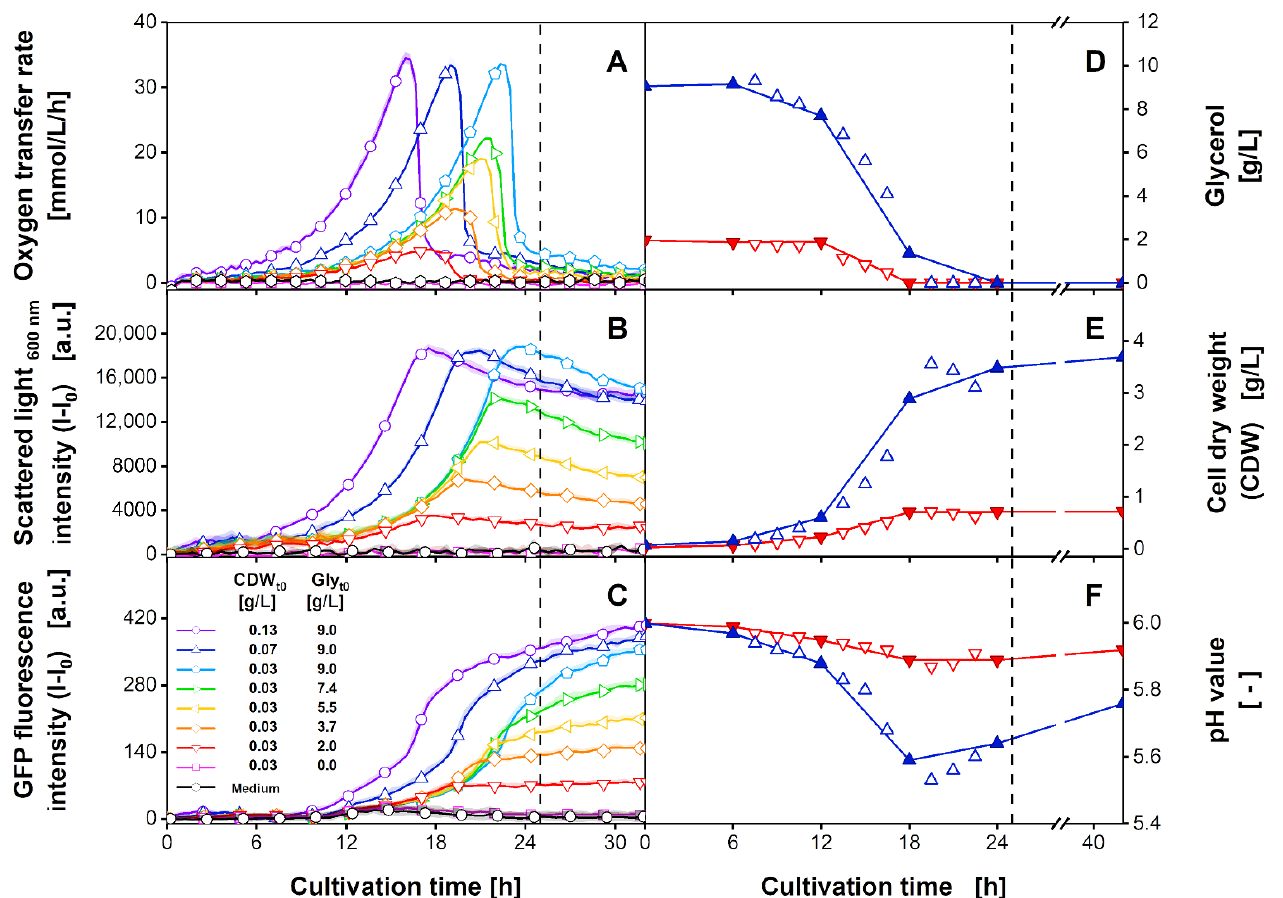
Figure 4. Time-resolved ( A – C ) online-monitoring signals and ( D – F ) offline sample measurements of H. polymorpha RB11 pC9- FMD (P FMD -GFP) cultivations in SYN6 medium at eight different initial cell dry weights (CDW t0 ) and glycerol concentrations (Gly t0 ). ( A ) Mean oxygen transfer rate (OTR) of cultures in triplicates determined by µRAMOS device [49]. Only every 5th data point is indicated by a hollow symbol for clarity. The standard deviation of triplicates is shown as shaded areas, which are barely visible due to good reproducibility. Singular online signals are shown in Figure S3. ( B ) Mean scattered light intensity at an excitation and emission wavelength of 600 nm and ( C ) mean GFP fluorescence intensity at an excitation wavelength of 420 nm and emission wavelength of 530 nm extracted from 2D spectra. Only every 5th data point is indicated by a hollow symbol for clarity. For inoculated cultures with glycerol concentrations above 0 g/L, scattered light and GFP signals describe mean values and standard deviation of six replicates, as described in Figure 2. For 0 g/L scattered light and GFP signals describe quadruplicates, while for medium wells the signals de- scribe duplicates. Values of ( D ) glycerol, ( E ) cell dry weight (CDW), and ( F ) pH value for initial biomass and glycerol concentrations of 0.07 g/L and 9.0 g/L (blue) as well as of 0.03 g/L and 2.0 g/L (red) are based on singular HPLC and at-line measurement from parallel cultivation as described in Figure 2. Hollow symbols show offline measurements for 1.5 h sampling interval, whereas linearly interpolated, filled symbols indicate a 6 h sampling interval. Dashed vertical lines after 25 h indicate the last measurement included for PLS model generation, as explained in the text. Spectroscopic measurement settings: excitation wavelength range = 280 nm–700 nm (step size = 10 nm), emission wavelength range = 278 nm–720 nm (step size = 0.45 nm), integration time = 30 ms. Cultivation conditions: 48-well microtiter plate with round geometry, liquid volume = 800 µL, shaking diameter = 3 mm, shaking frequency = 1000 rpm, temperature = 30 °C.